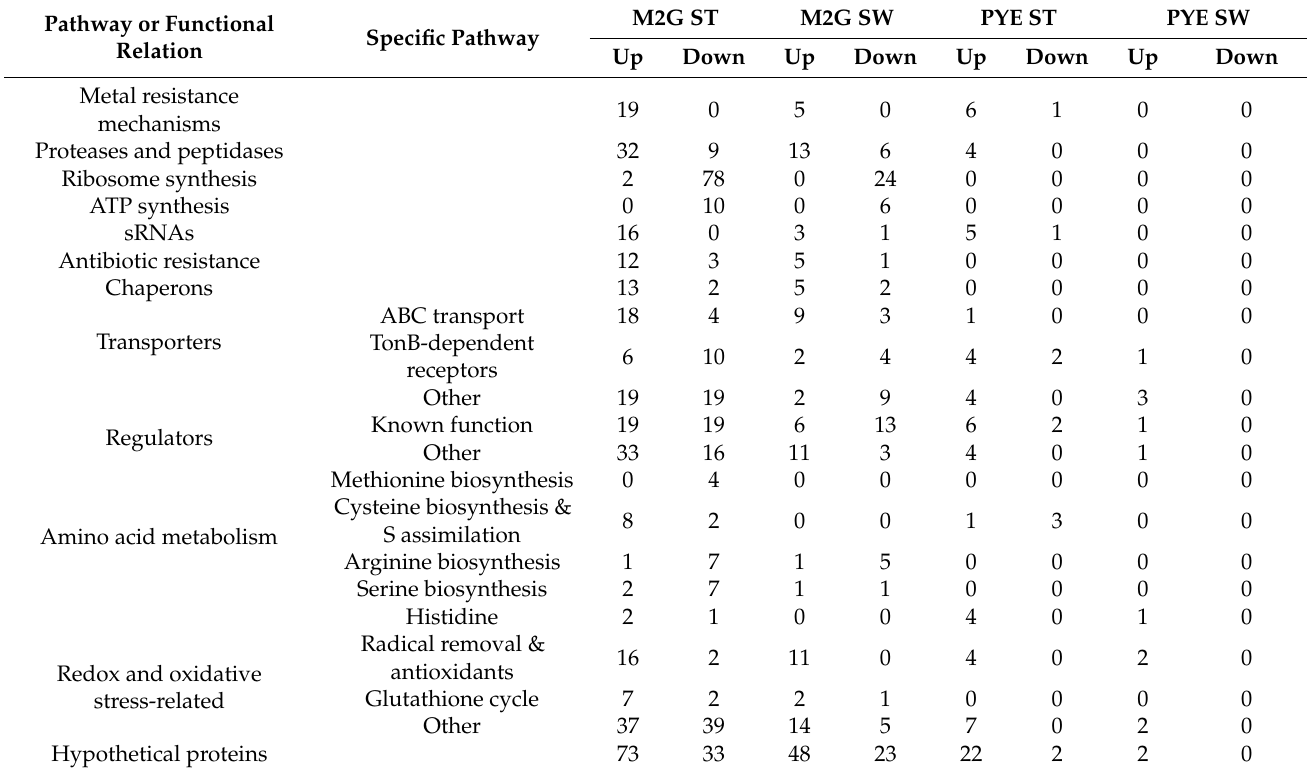
Table 1. Overview of functional roles of differentially regulated genes in all Cu-CT